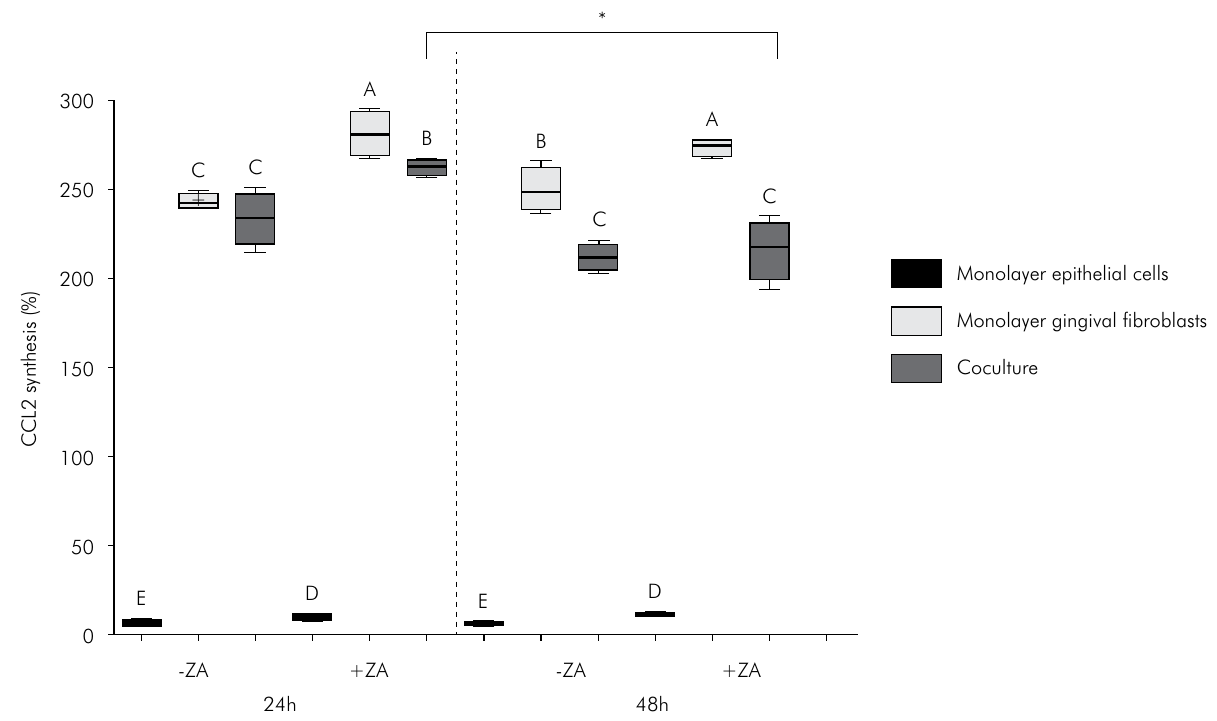
Figure 4. Synthesis of CCL2 by the gingival fibroblasts that were treated with ZA in both the monolayer and co-culture models. The boxplots represent the median (25 th to 75 th percentiles) values. The different letter labels indicate statistically significant differences for each period (Mann-Whitney, p < 0.05). *statistically significant difference between the groups at 24 h and 48